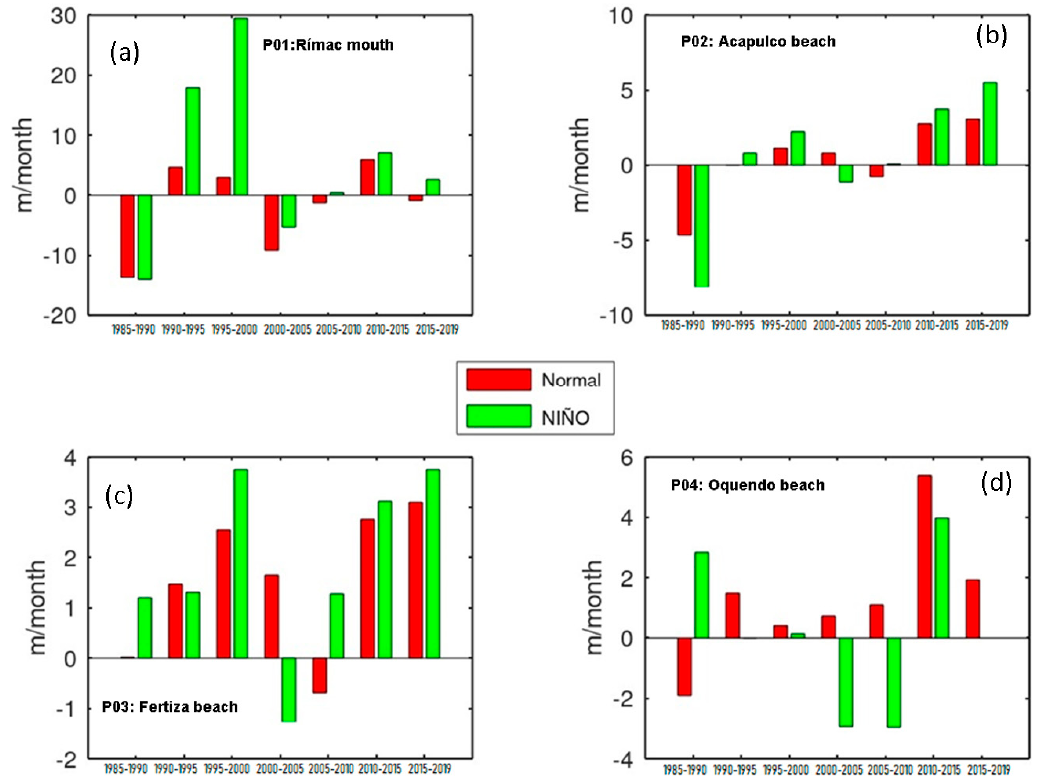
Figure 15. Average erosion and accretion rate in control points. Red bar: normal year and green bar: El Niño, ( a ) P01: Rimac mouth, ( b ) P02: Acapulco beach, ( c ) P03: Fertiza beach, ( d ) P04: Oquendo beach